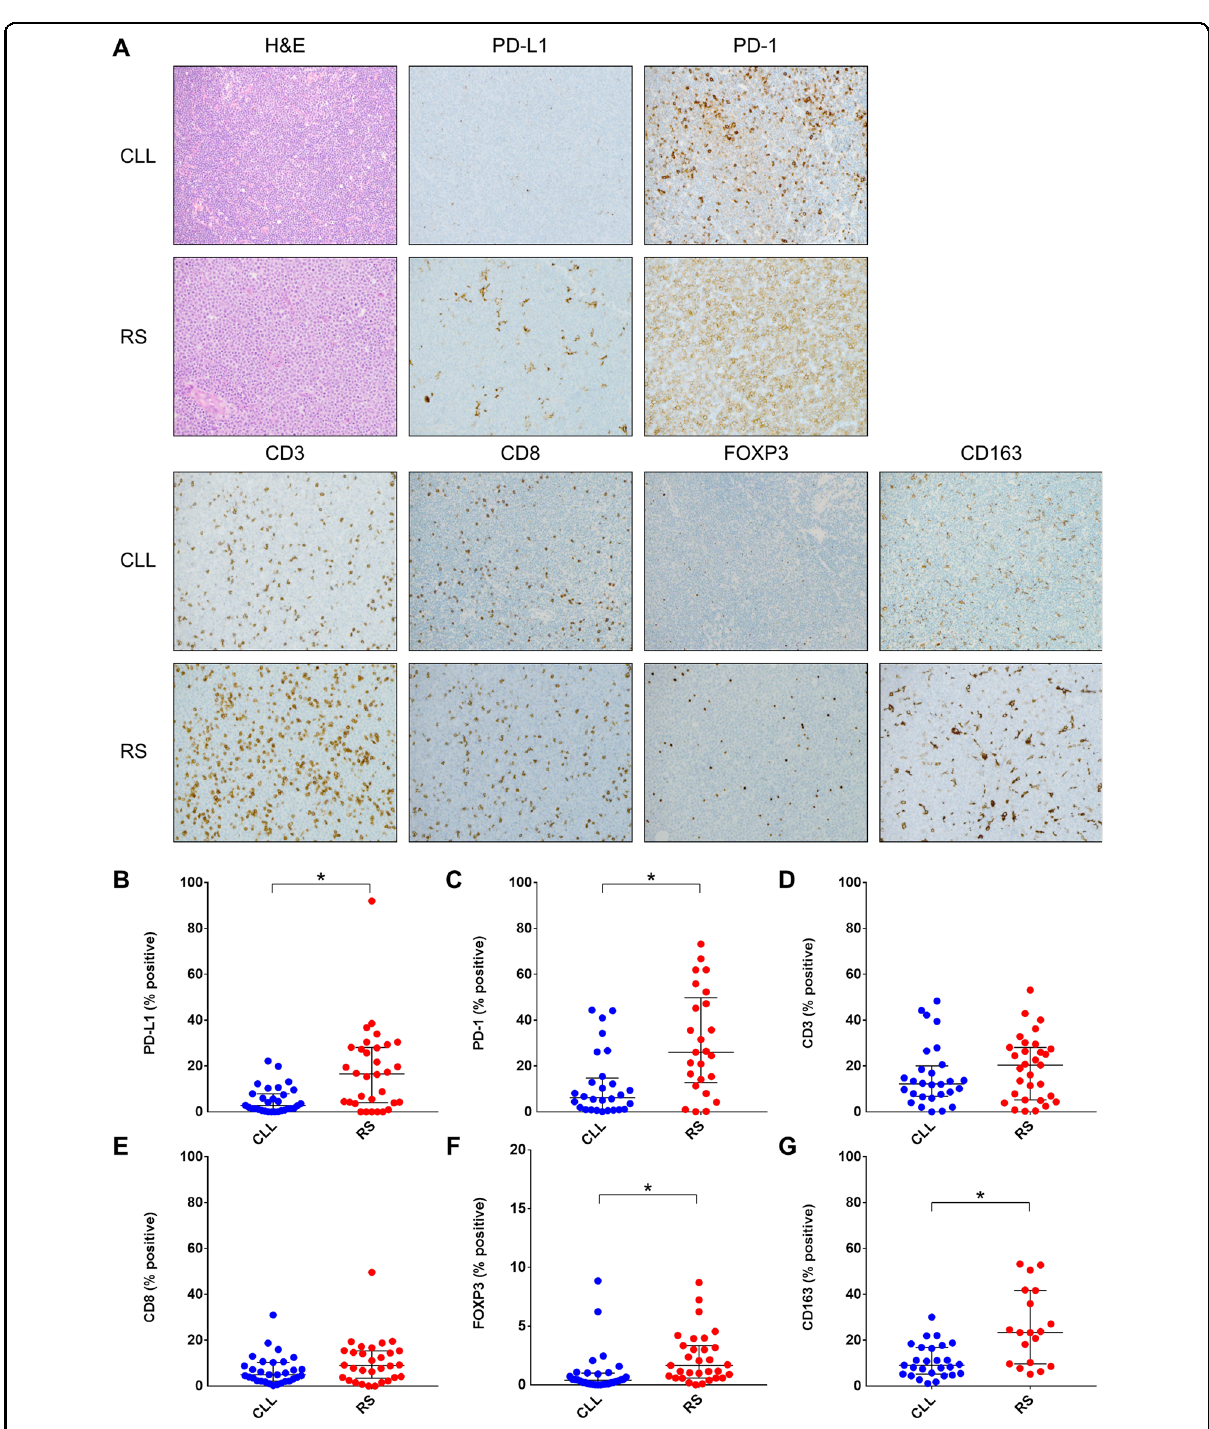
Fig. 1 Immunohistochemistry staining of immune checkpoint and immune cell markers in CLL and RS. A Representative H&E and IHC images of PD-L1, PD1, CD3, CD8, FOXP3, and CD163 staining in CLL and RS. B – G Quantitative comparison of PD-L1, PD1, CD3, CD8, FOXP3, and CD163 staining in CLL vs. RS. Asterisk (*) indicates P <